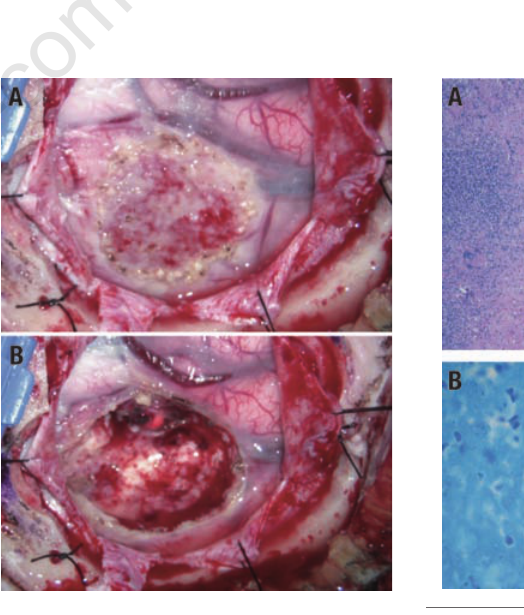
Figure 3. Pathological examination of tumor. A) Hematoxylin and eosin staining show necrotizing granulomas with periph- eral palisading epithelioid histiocytes, giant cells. B) Acid fast